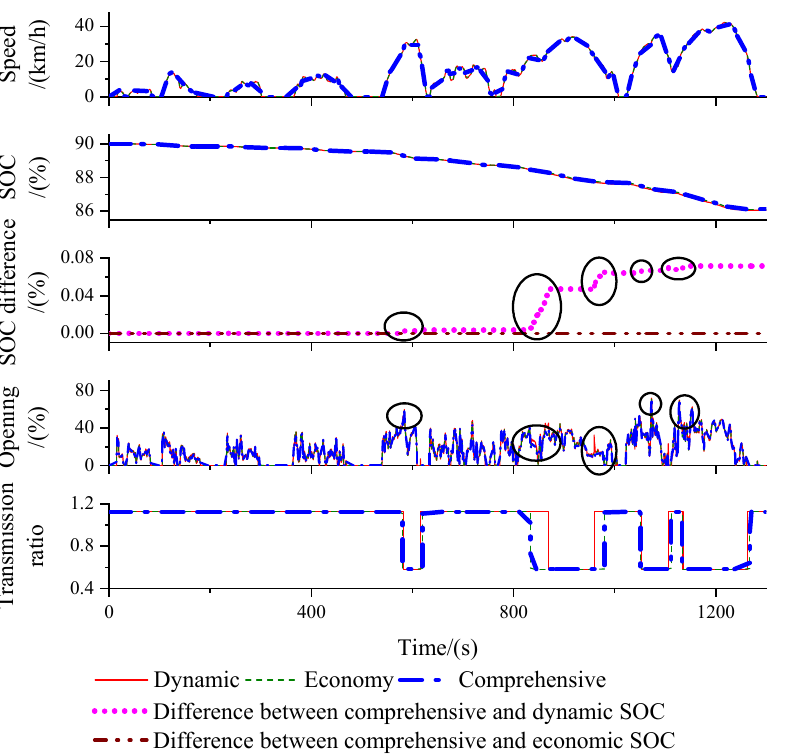
Figure 27. The simulation results of the energy consumption of three shift patterns. Dynamic Performance